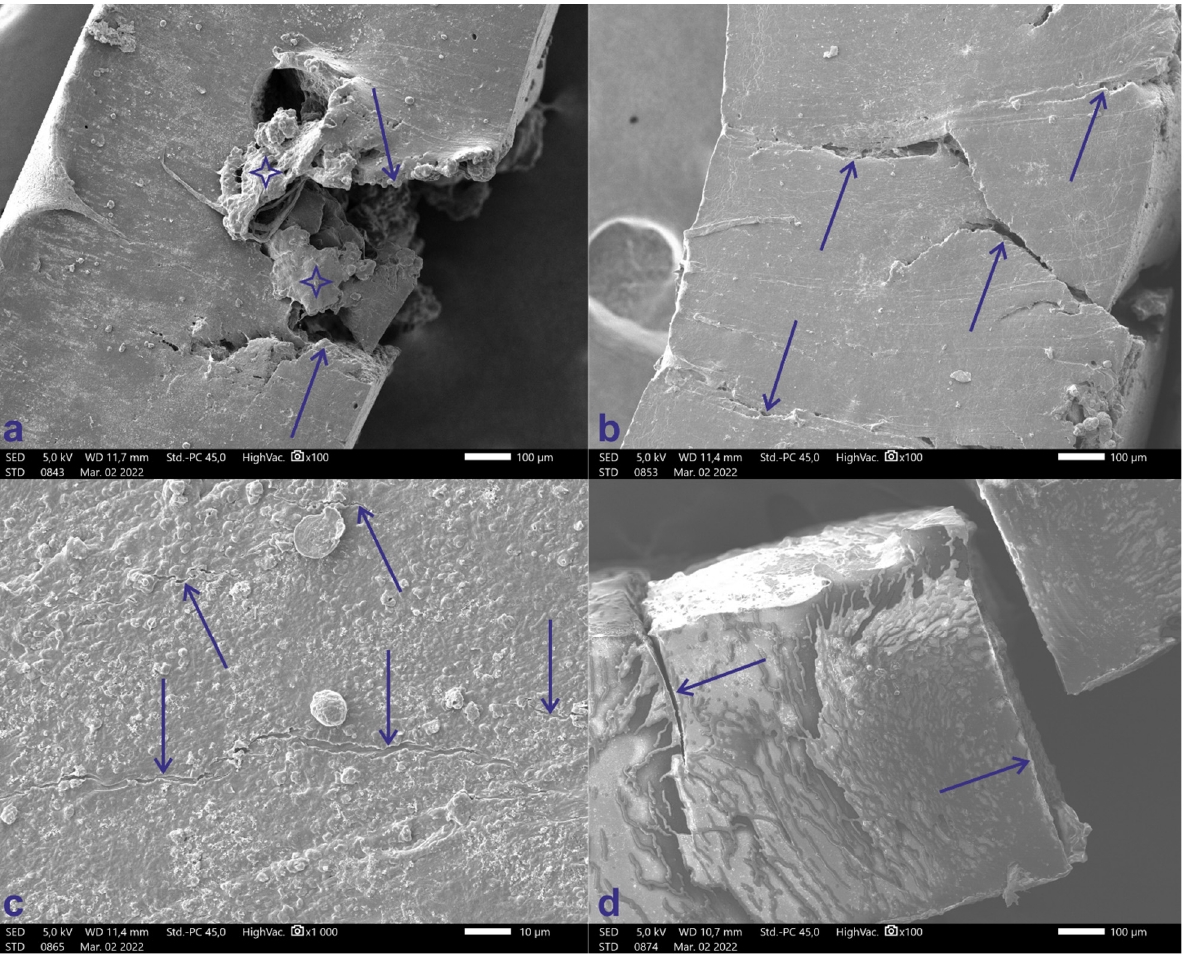
Figure 8. ( a ) SEM record of Lion ligature at 100× magnification. Arrows show the irregular shape of the crack, blue stars indicating the fluffing. ( b ) Red cat SEM recorded at 100× magnification. Arrows show the irregular shape of the crack. ( c ) Gorilla ligature SEM recorded at 1000× magnification. Only small cracks are visible on the surface (blue arrows). ( d ) Horse carriage ligature SEM recorded at 100× magnification. The cracks are rectilinear and perpendicular to the outer surface.